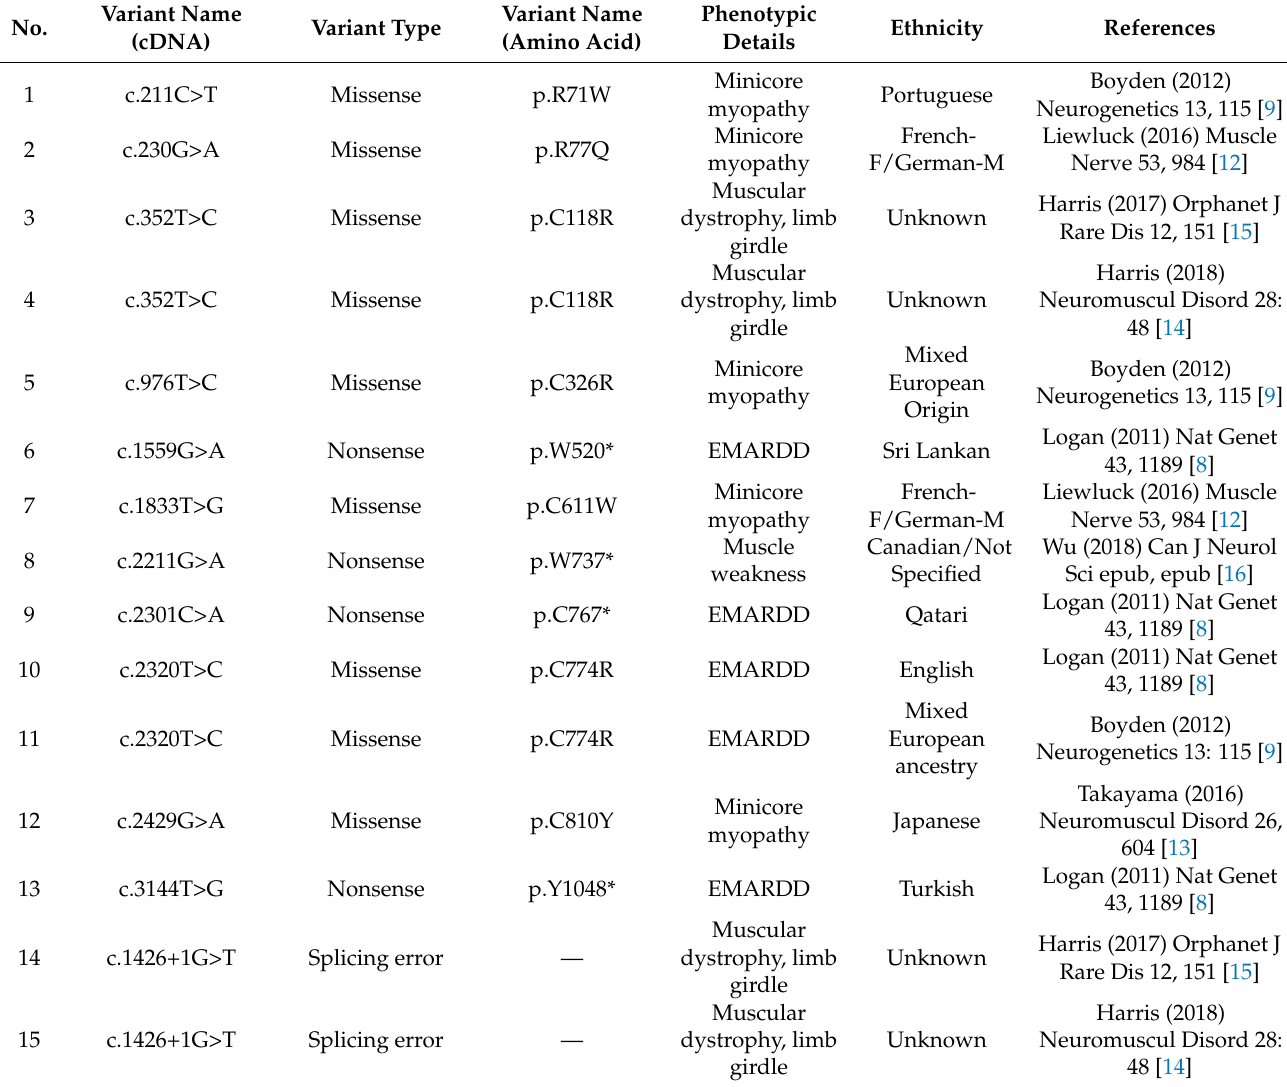
Table 2. List of previously reported pathogenic variants in MEGF10 found in the